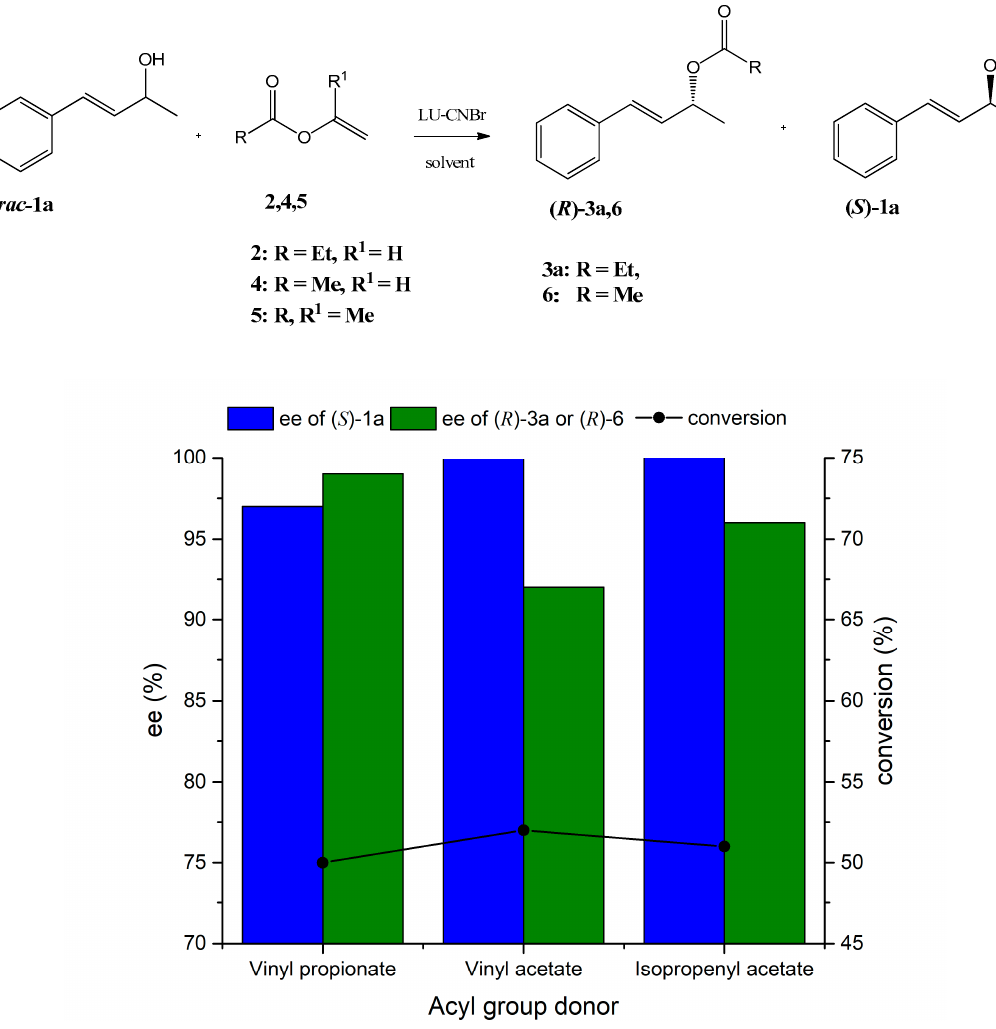
Figure 3. The effect of the acyl donor on the kinetic resolution of racemic alcohol 1a in the process of transesterification catalyzed by LU ‐ CNBr (24 h reaction in DIPE, 0.06 U of enzyme).